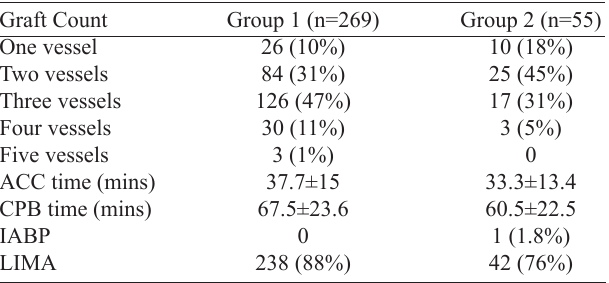
Table 3. Operative data of the